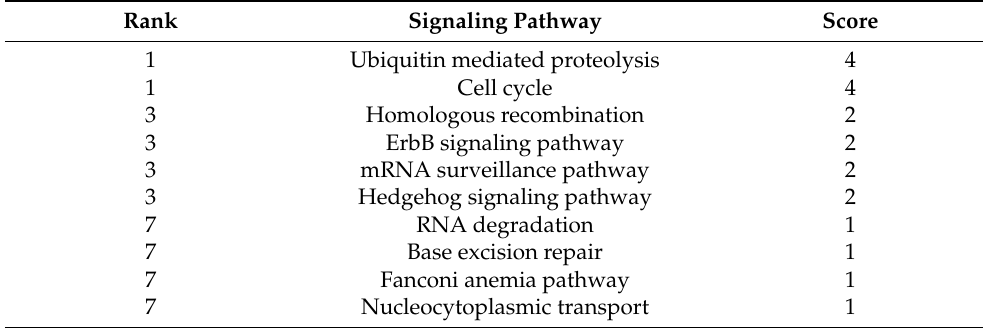
Table 2. Top 10 hub pathways of genes included in a and b ranked by MCC method.